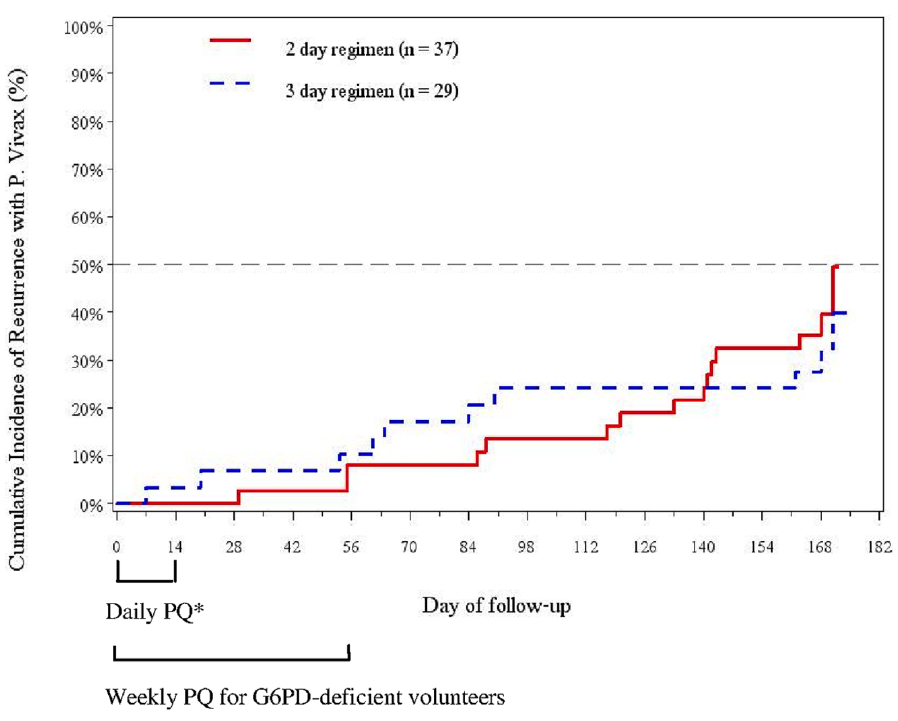
Figure 6. Six-month cumulative incidence of reported vivax recurrence following primaquine administration. Cumulative incidence (Kaplan-Meier) of reported vivax recurrence in 2-day (n=37) versus 3-day (n=29) regimens following primaquine (PQ) administration at study discharge by monthly follow-up in 66 volunteers over 6 months (P=0.62). Six cohort volunteers who were not randomized to dihydroartemisinin- piperaquine treatment also developed vivax infection and received primaquine, but are not included in analysis above. *G6PD-normal volunteers received daily primaquine30mg for 14 days whereas G6PD-deficient volunteers received a weekly regimen of 45mg for 8 weeks.